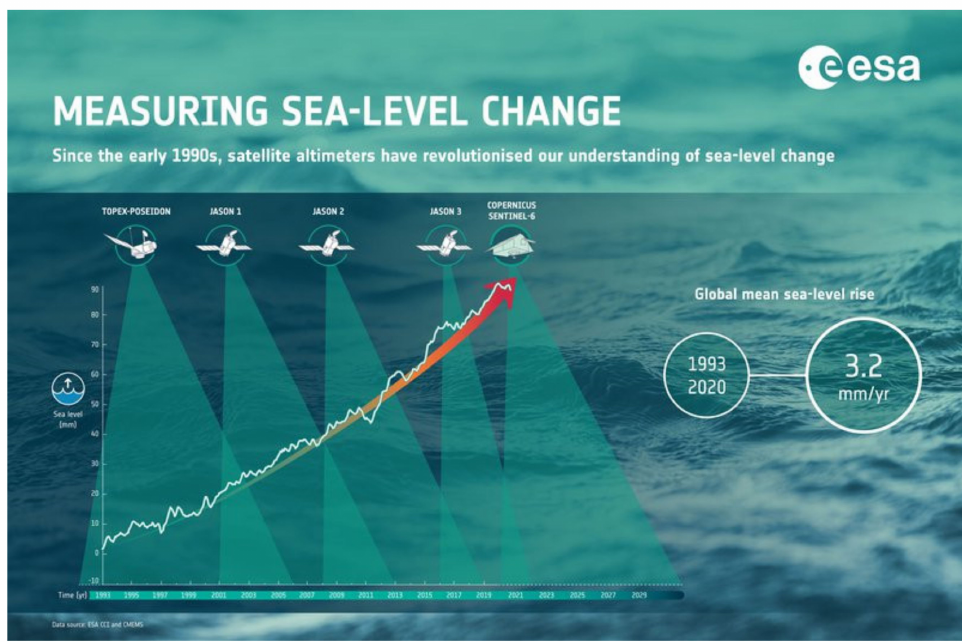
Figure 4. Global mean sea level (seasonal signals removed). Climate Change Initiative. Courtesy of ESA. https://climate.esa.int/en/news-events/coastal-observations-boosted-new-reference-satellite/ (accessed on 21 December